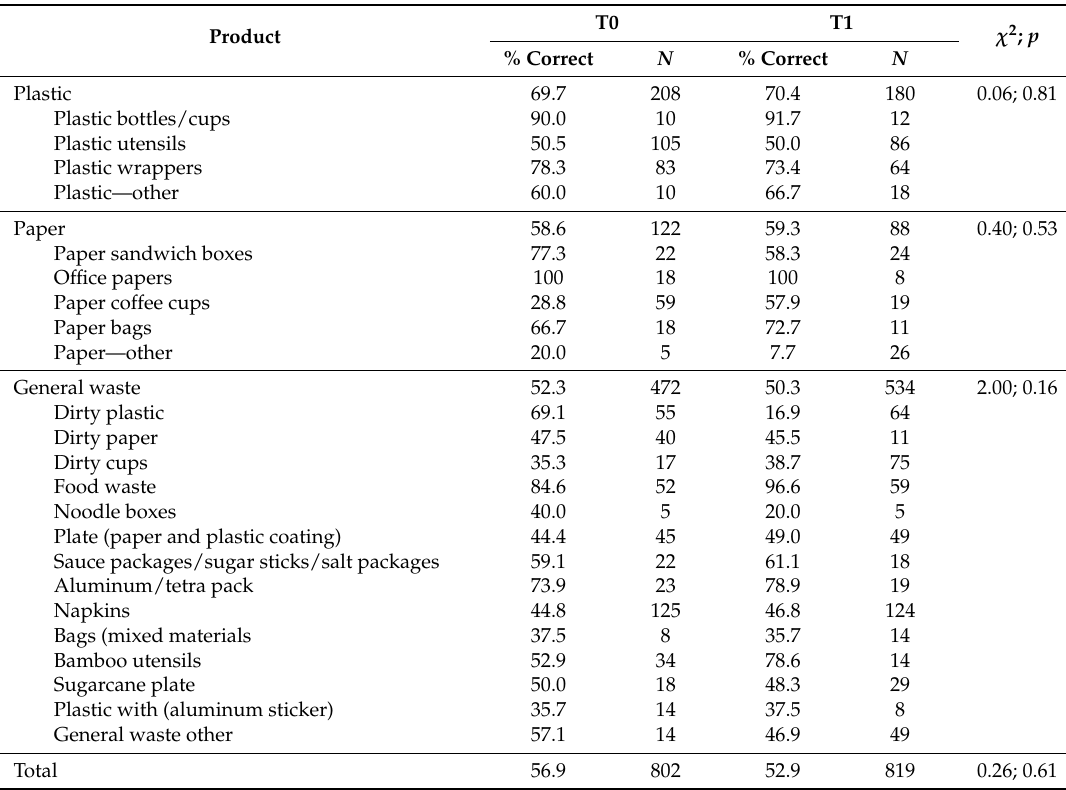
Table 4. (In)Correctly sorted waste at T0 and